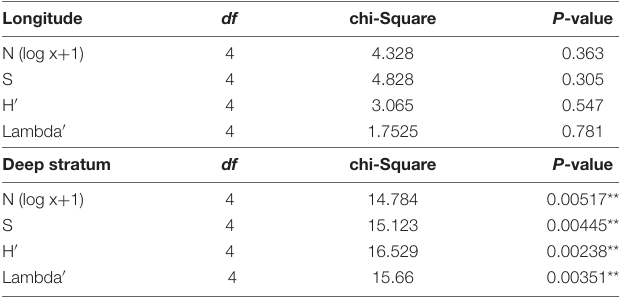
TABLE 2 | Kruskal-Wallis to test the influence of longitude and depth stratum on abundance, species richness, and diversity of copepods in the SPSG. Longitude df chi-Square